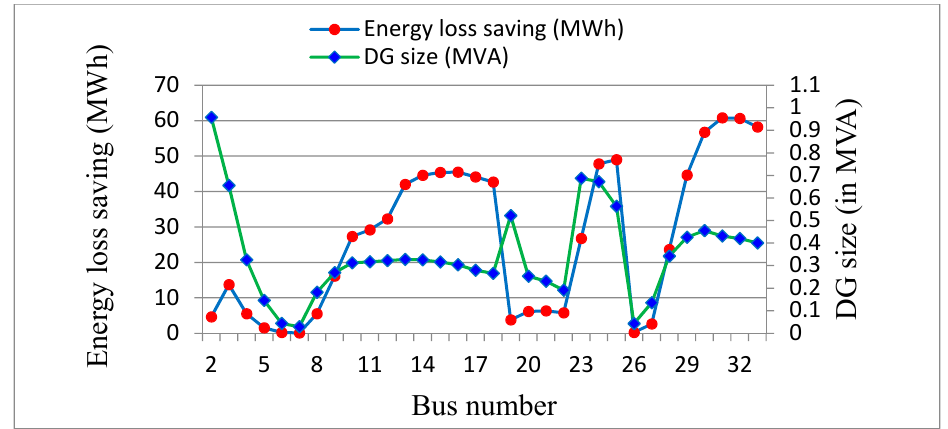
Figure 15. Optimal DG size (in MVA) and corresponding energy loss saving (in MWh) with DG at node 6 for various nodes for the IEEE 33-bus system.